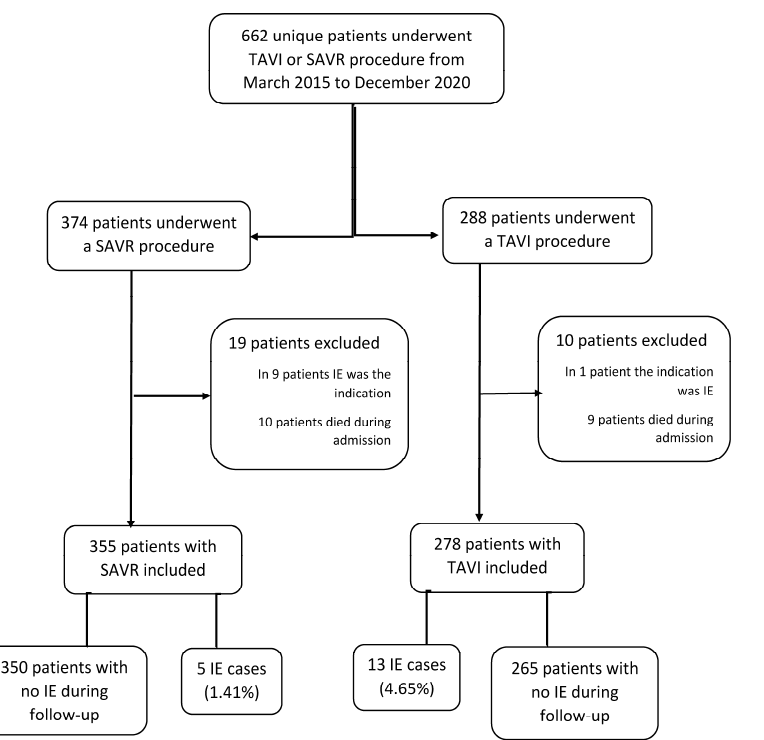
Figure 1. Patient’s flowchart. TAVI: Transcatheter aortic valve implantation. SAVR: Surgical aortic valve replacement. IE: infective endocarditis. Table 1. Baseline characteristics and IR occurrence after TAVI vs. SAVR. TAVI: Transcatheter aortic valve implantation. SAVR: Surgical aortic valve implantation. CI: Charlson Index. COPD: Chronic obstructive pulmonary disease. CIED: Cardiac Implantable Electronic Device. GFR: